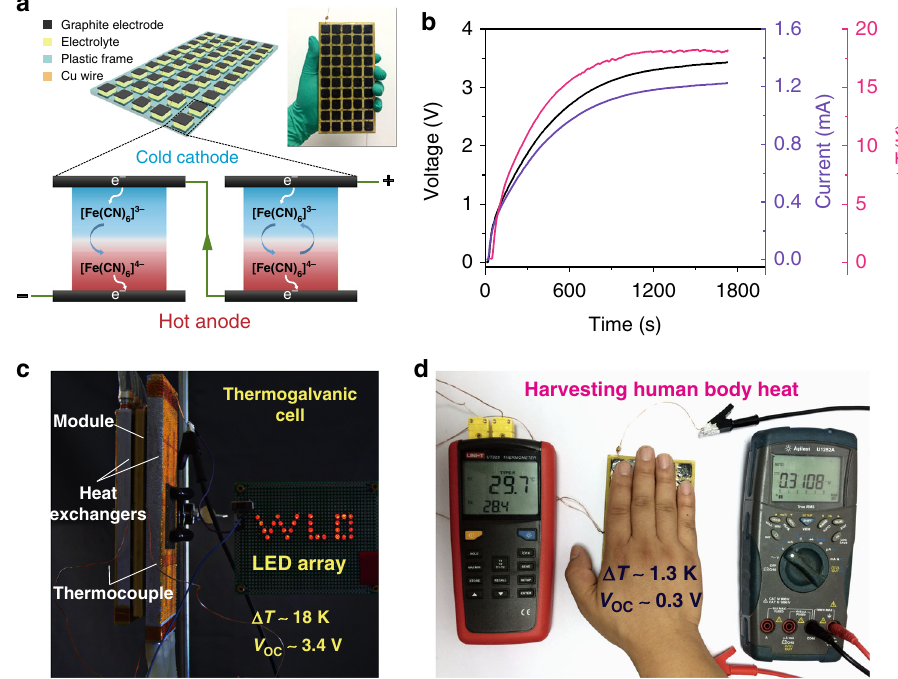
Fig. 4 Demonstration of the harvest of low-grade heat by a prototype module. a Schematic of the structure and a photograph of the module. b Voltage and current curves of the module corresponding to the applied temperature difference. c Image of the module directly powering an LED array containing 29 red LED lamp beads. The module was sandwiched by two aluminum heat exchangers with water as the heat transfer fl uid. The temperatures of the cold and hot water were controlled at approximately 278 and 333 K, respectively. Because of inevitable thermal conduction in the module and thermal contact resistance between the module and heat exchangers, the Δ T of 18 K built on the module at the steady state was smaller than that of the two heat exchangers. d Harvesting heat energy from the human body. The module was placed on a steel platform as a heat sink with a temperature of approximately 298 K and then covered by one hand. After several minutes, a stable temperature difference of 1.3 K was built, which induced an output of approximately 0.3 V by the module. The temperature and voltage were measured by a thermometer (left) and multimeter (right),